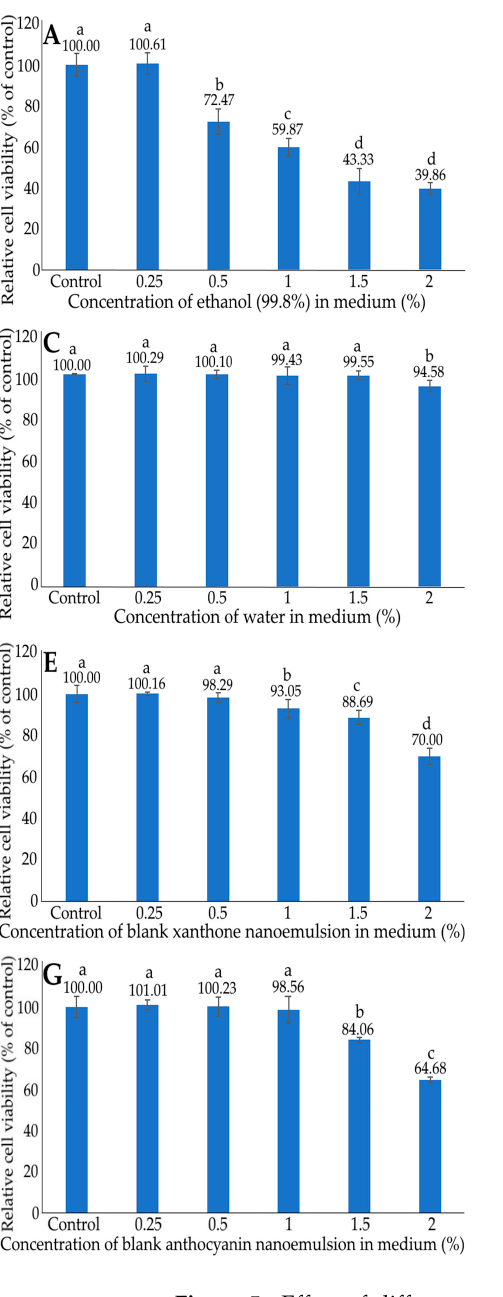
Figure 5. Effect of different concentrations of ethanol ( A , B ), deionized water ( C , D ), blank xanthone nanoemulsion ( E , F ) and blank anthocyanin nanoemulsion ( G , H ) on liver normal cells AML12 ( A , C , E , G ) and liver cancer cells HepG2 ( B , D , F , H ) after 48 h incubation as measured by MTT assay. Data shown are mean ± standard deviation (n = 3) and data with different small letters (a–d) are significantly different at p < 0.05.